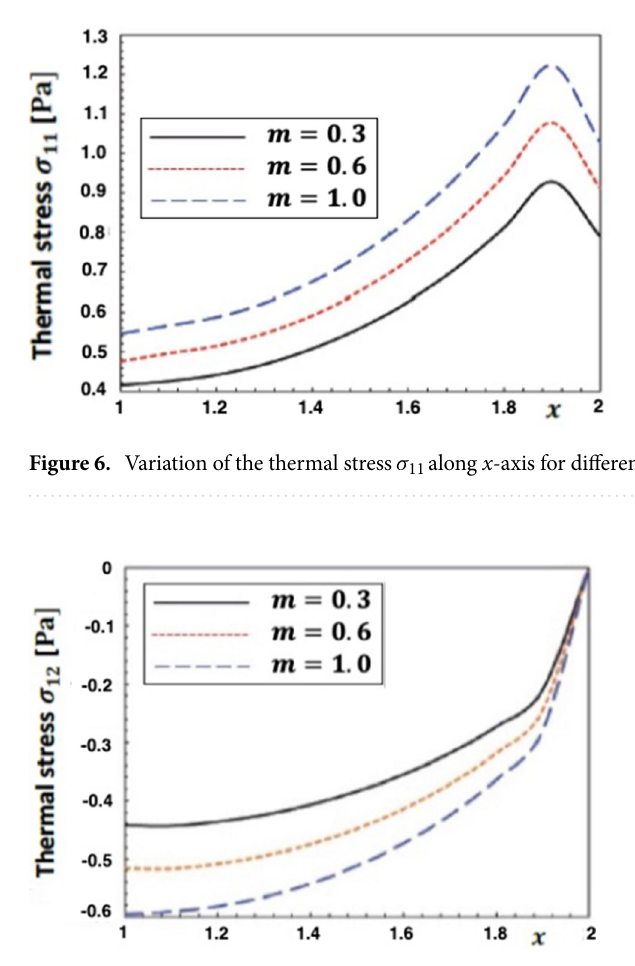
Figure 7. Variation of the thermal stress σ 12 along x -axis for different values of functionally graded